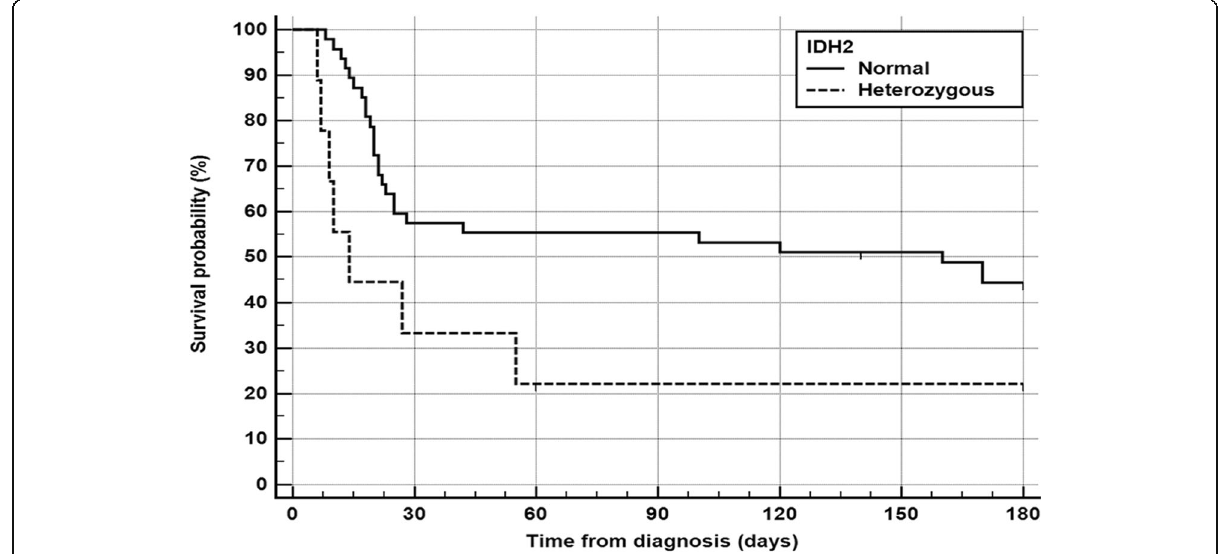
Fig. 3 Kaplan-Meier survival curves in patients with normal or heterozygous IDH2. There is a statistically significant difference between both curves ( χ 2 [1] = 4.893, p value = 0.027, hazard ratio = 2.460, 95% CI = 0.784 –